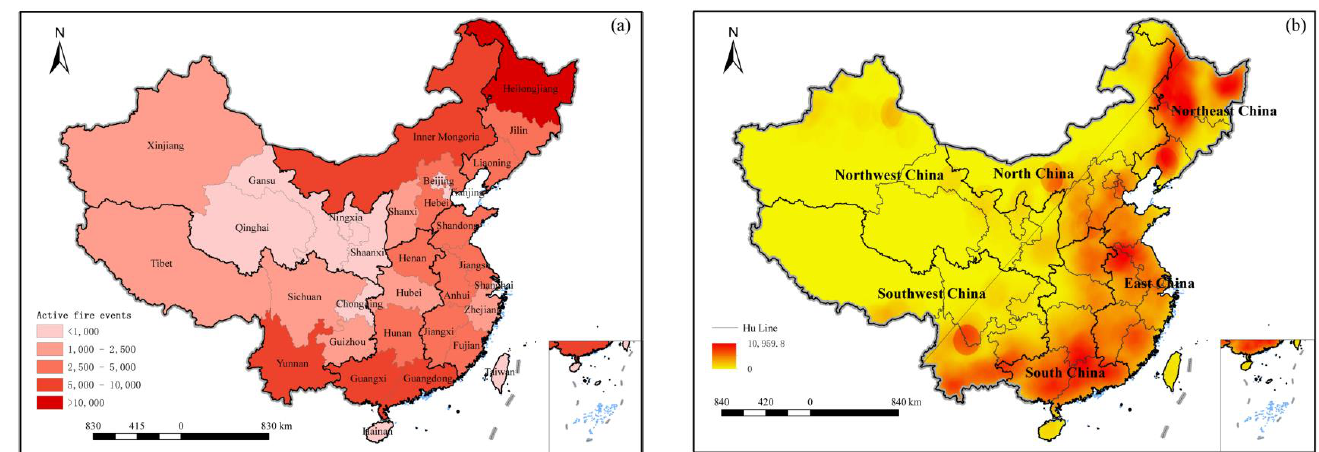
Figure 2. Maps of the ( a ) spatial distribution of the annual average number and ( b ) patterns of hotspot density (1 km × 1 km) of MODIS active fires in China during 2001 – 2020.